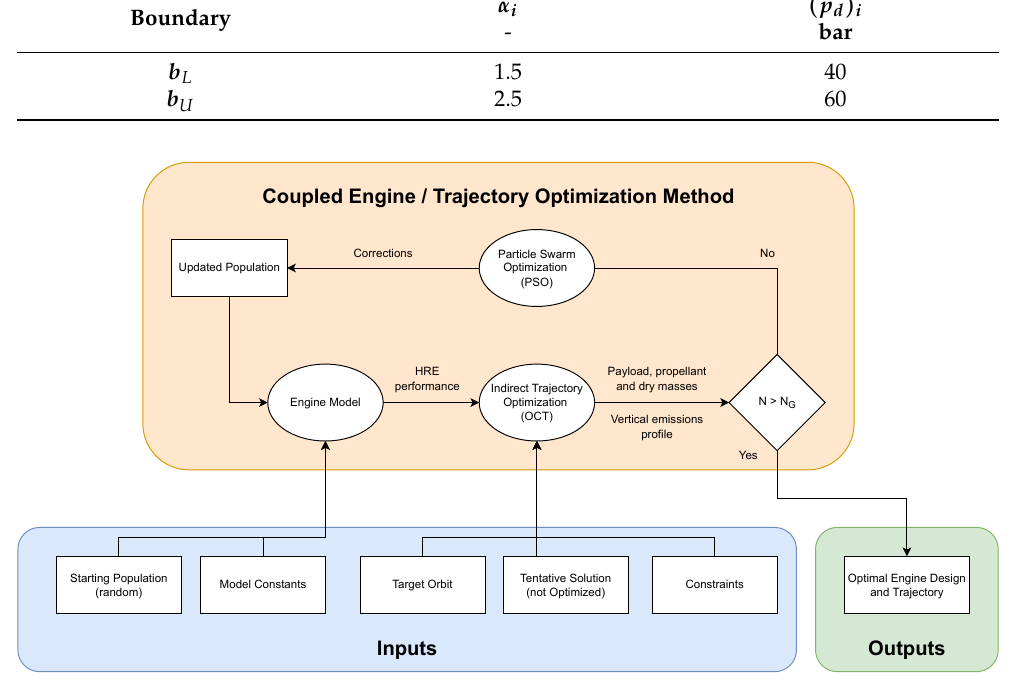
Figure 2. Coupled optimization procedure flow chart. The optimization procedure stops when the number of generation reaches N G =